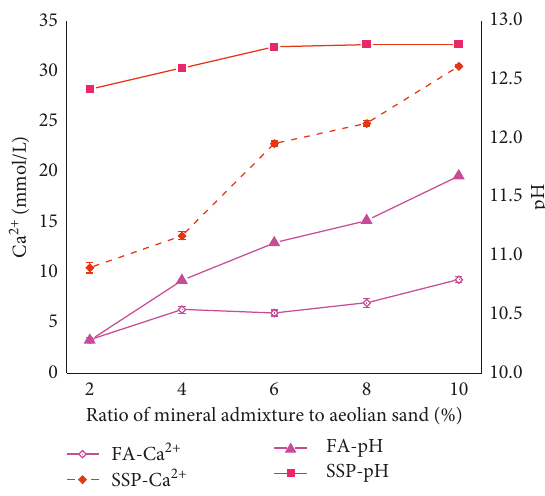
Figure 4: Variations in Ca 2+ concentration and pH of the steel slag powder and fly ash solutions with different replacement rates.